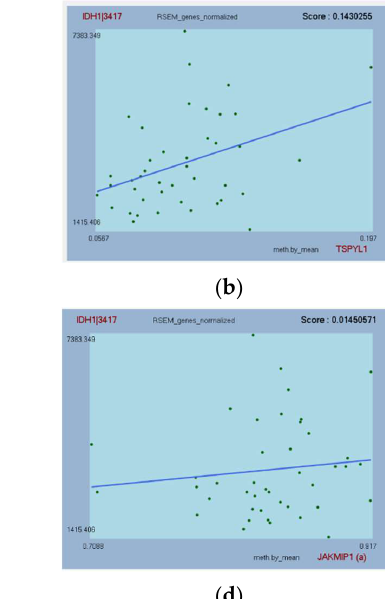
Figure 2. Results of the survival analysis with risk tables and Kaplan–Meier curves comparing overall survival of patients with high vs. low mRNA expression (median split). Each of the genes ( a ) TSPYL2; ( b ) JAKMIP1; ( c ) CIT; and ( d ) TMTC1 were prognostic for GBM (IDH-wildtype; p < 0.001; Log-rank test). TMTC1 was also prognostic for recurrent GBM (IDH-wildtype; p < 0.05; Log-rank test; not shown).